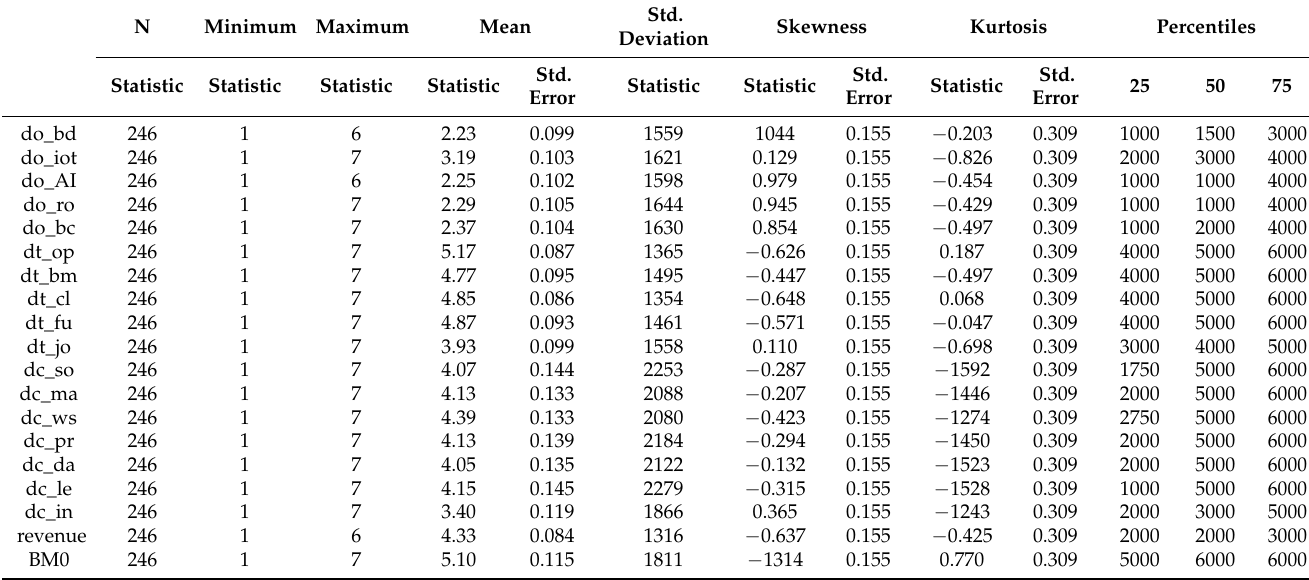
Table A1. Descriptive statistics of survey